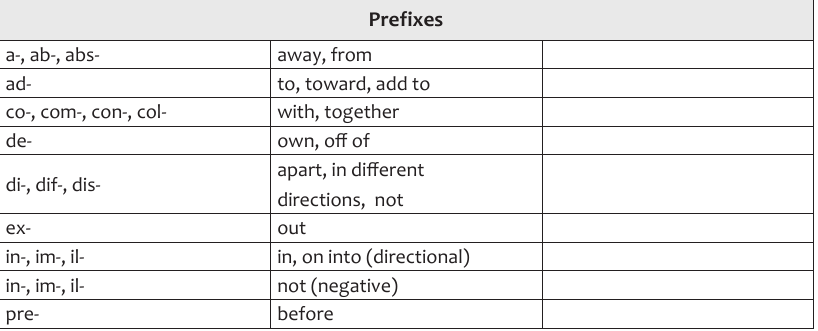
Table 3: Elementary Level Latin and Greek Roots and Affixes (Rasinki et al., 2011: